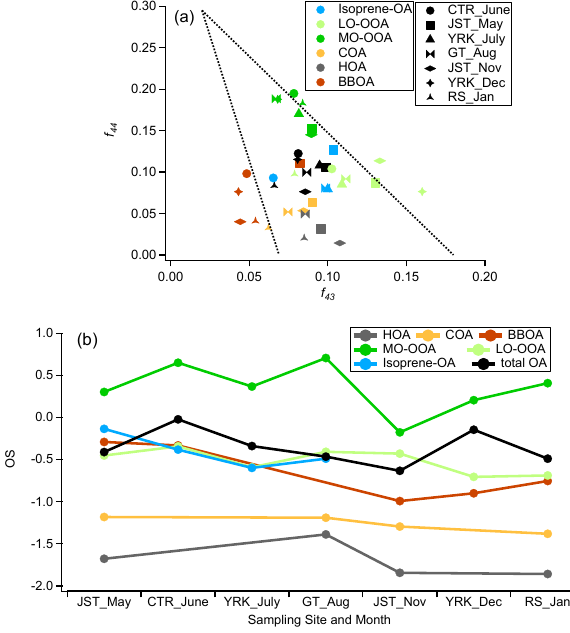
Figure 4. (a) f 44 vs. f 43 for total OA and OA factors resolved from PMF analysis on organic mass spectra only (i.e., PMF org ). (b) The oxidation state of OA